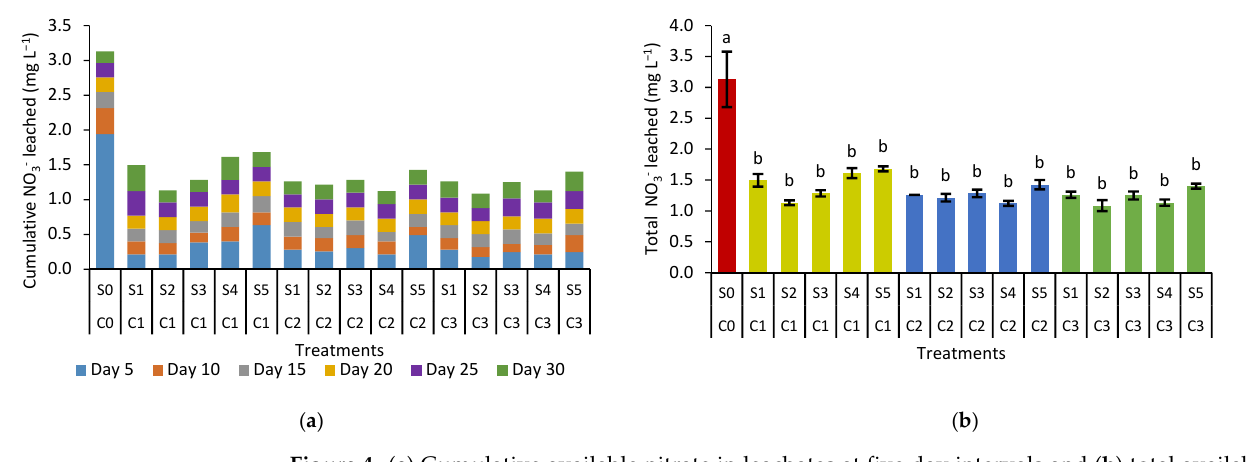
Figure 4. ( a ) Cumulative available nitrate in leachates at five day intervals and ( b ) total available nitrate in leachates for the different treatments after thirty days of leaching. Different letters indicate significant mean differences using Tukey’s HSD test at p ≤ 0.05. Error bars represent the standard error of the mean.